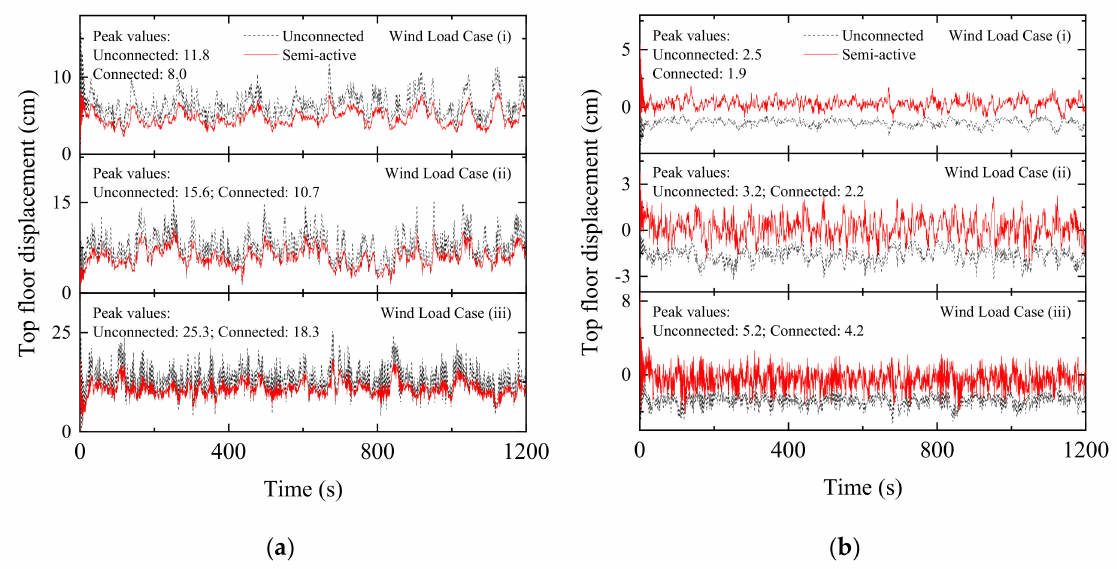
Figure 23. Time history of top floor displacement under wind excitation in: ( a ) a building on the upwind side and ( b ) a building on the downwind side when flexible adjacent buildings are connected using semi-active MR dampers following damper Configuration